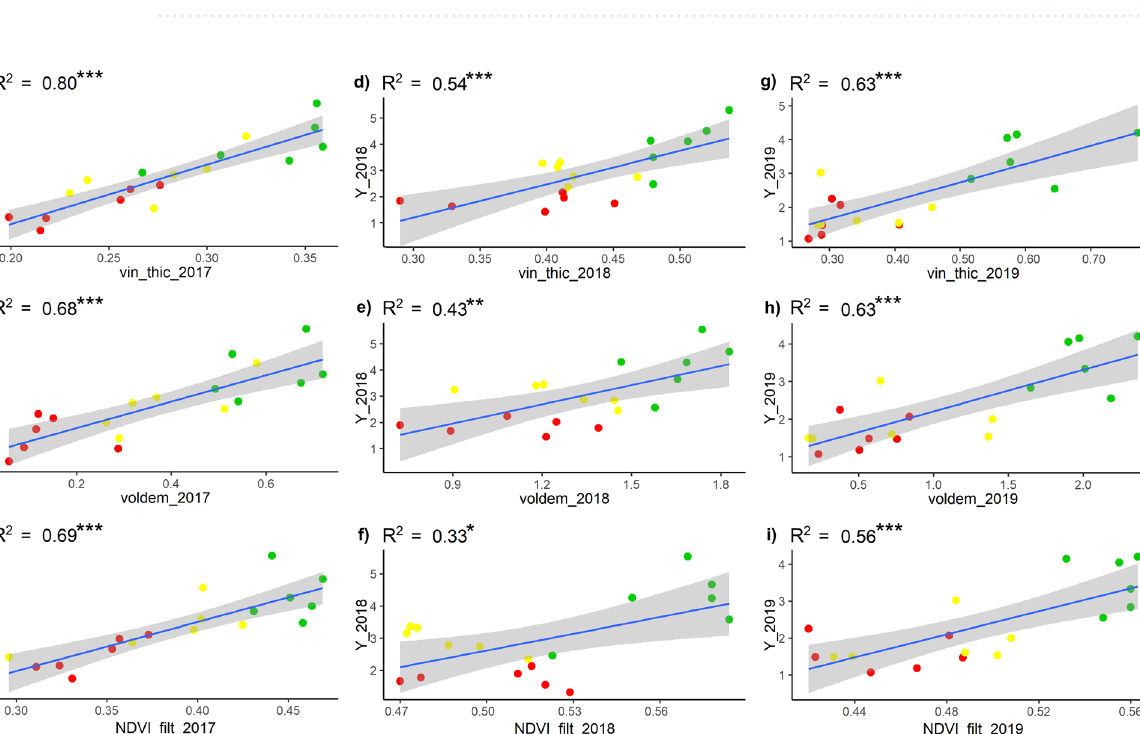
Table 3. Productive and vegetative characterization of vines within each vigour zone during 2017, 2018 and 2019 seasons (mean and standard deviation).